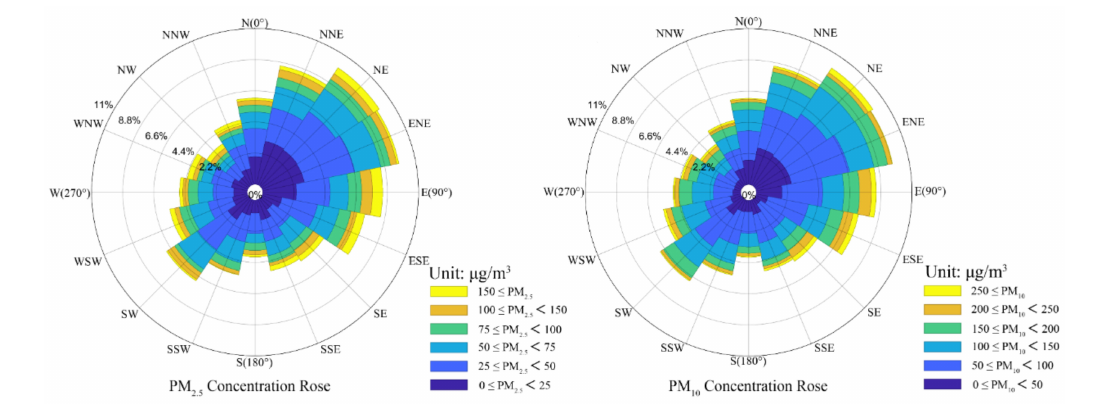
Figure 5. Pollutant rose diagram of wind direction and PM concentration.